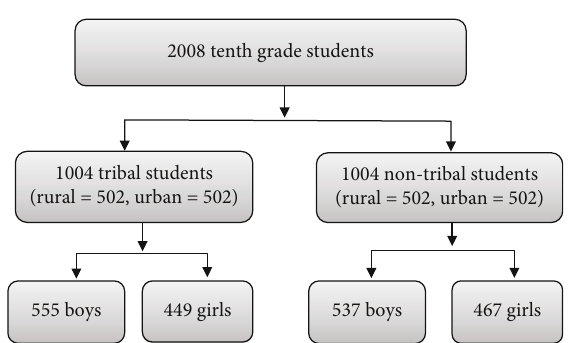
Figure 1: Sample frame of tenth grade.